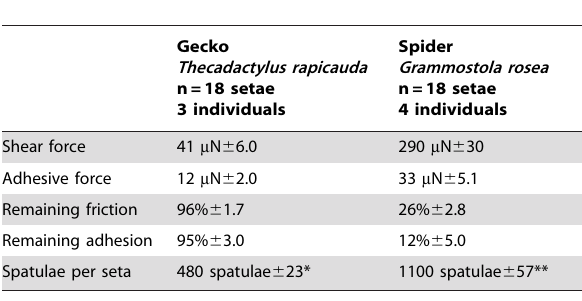
Table 2. Direct comparison of single seta force in a gecko and a spider (mean 6 SE).